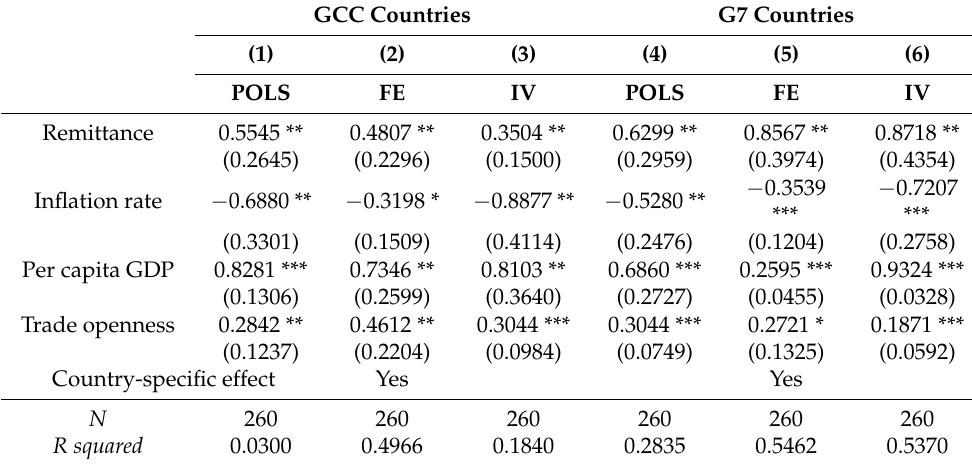
Table 5. Impact of remittance on liquid